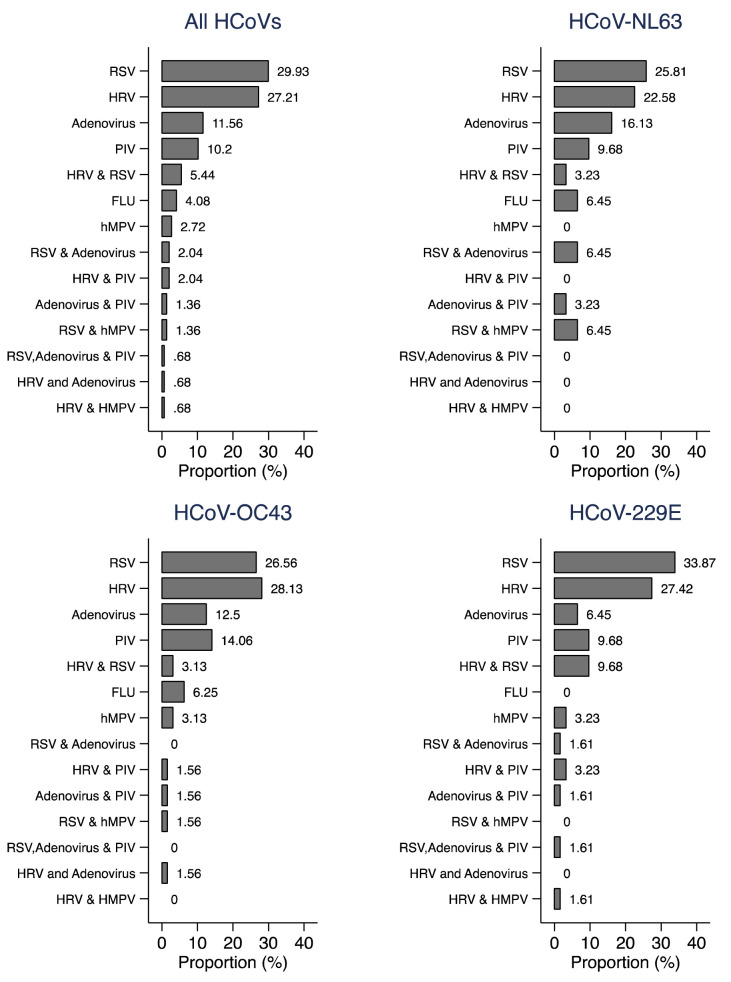
Percentage distribution of coinfections between HCoVs and other viral pathogens for pneumonia cases admitted to Kilifi County Hospital, Kilifi, Kenya 2007–2019.RSV=respiratory syncytial virus (A and B), HRV=human rhinovirus, PIV=parainfluenza, FLU=influenza (A, B and C), hMPV= human metapneumovirus.